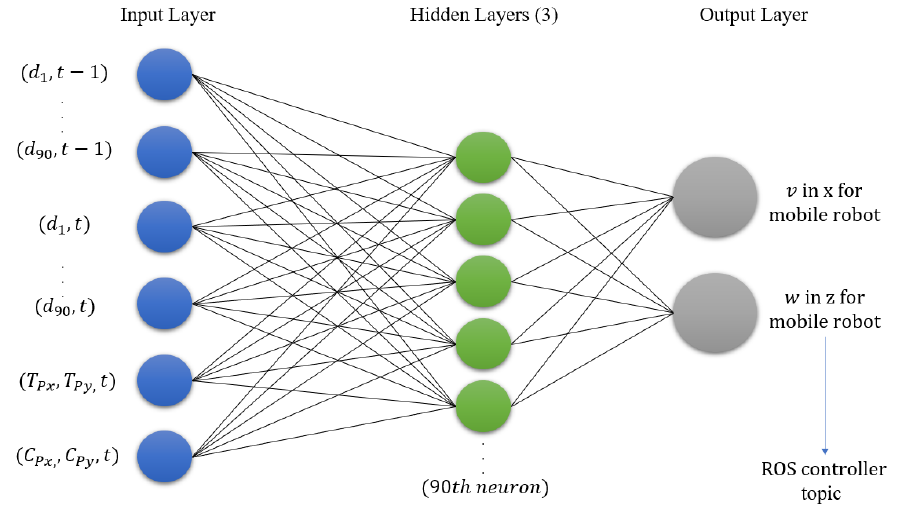
Figure 8. LSTM model architecture.